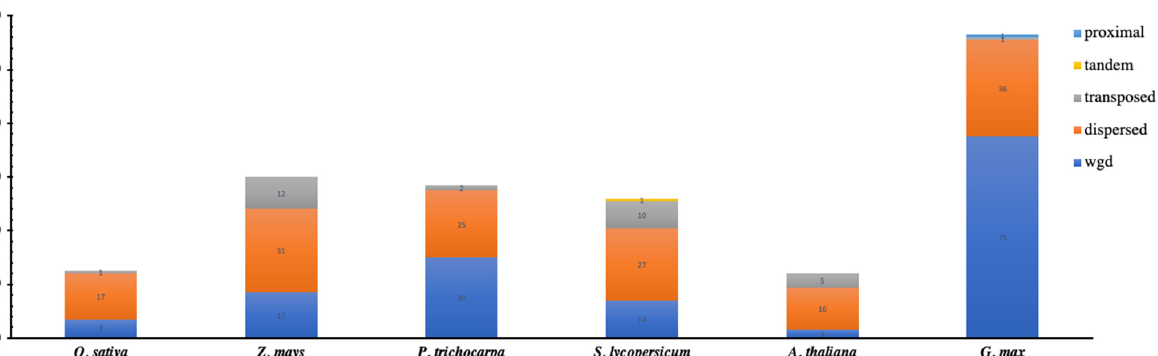
Figure 8. Gene duplication events in different plant species and color backgrounds on the bars represent different gene duplication events.